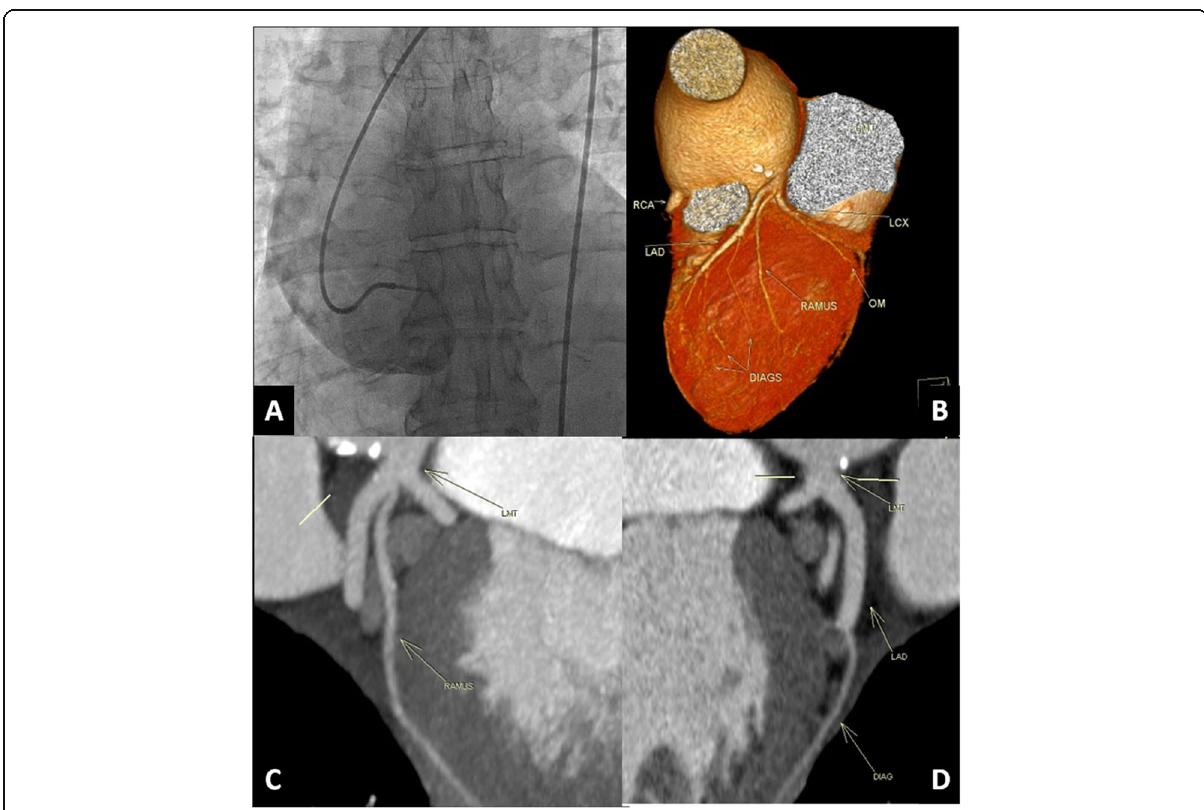
Fig. 2 Demonstration of a case of severe aortic regurgitation with dilated aortic root. A Non-selective injection of contrast by catheter due to the difficult engagement of the left main trunk. B Volume-rendering technique (VRT) by CCTA shows the anatomy of different coronary arteries. C , D Multiplanar reconstruction (MPR) of CCTA reveals the normal LAD, ramus, LCX, and diagonal